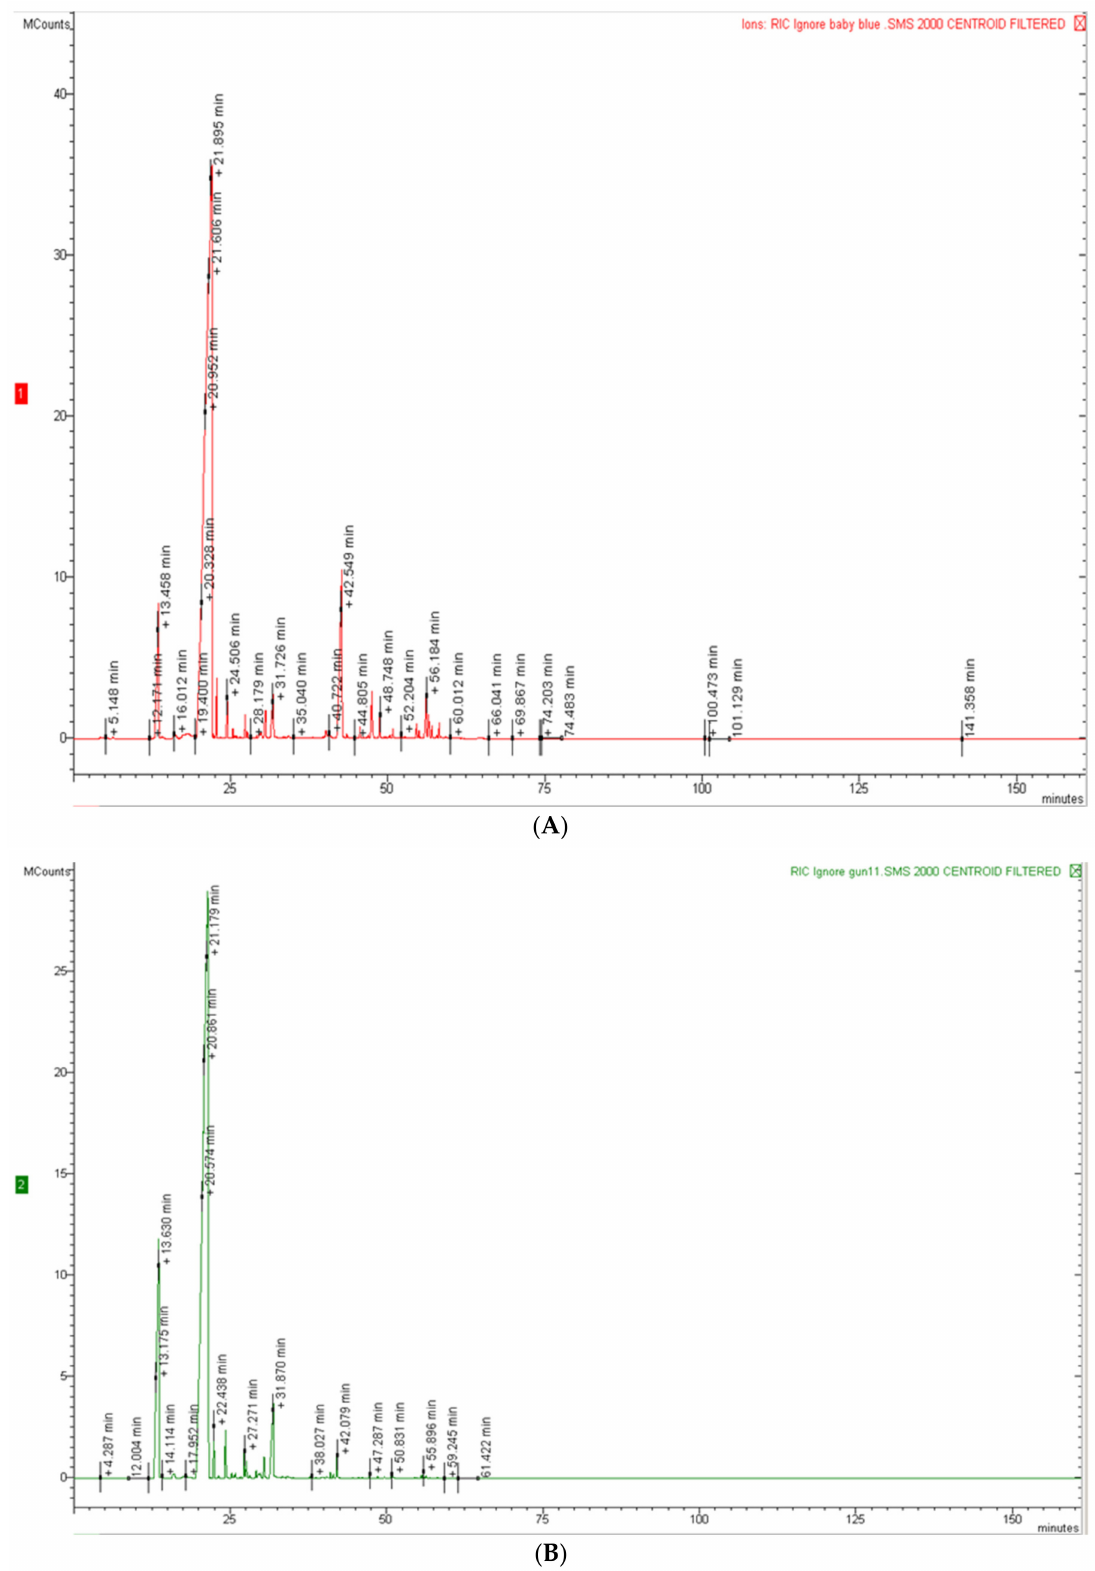
Figure 6. GC chromatograms of E. pulverulenta ‘Baby blue’ (EP) ( A ) and E. gunnii (EG) ( B )